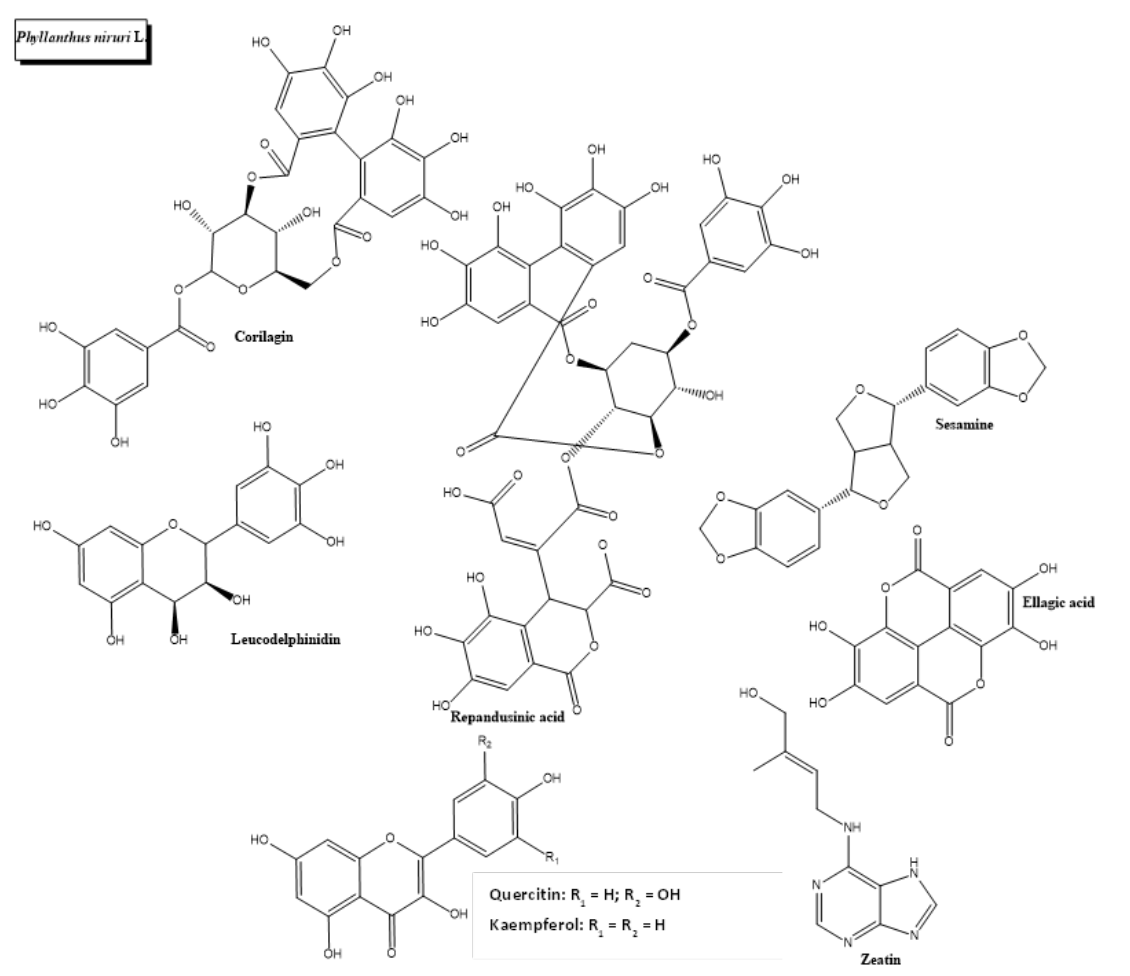
Figure 9. Chemical structures of bioactive phytocompounds with reported antidiabetic properties identified in Phyllanthus niruri L. identified in Phyllanthus niruri